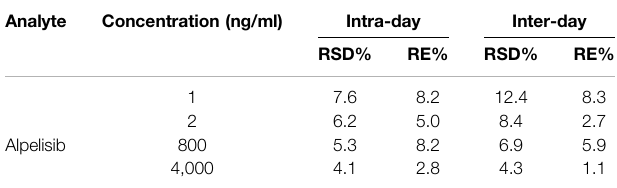
Table 1 . All the data were manipulated using the Quanlynx program with Masslynx 4.1 software (Milford, MA, United States).